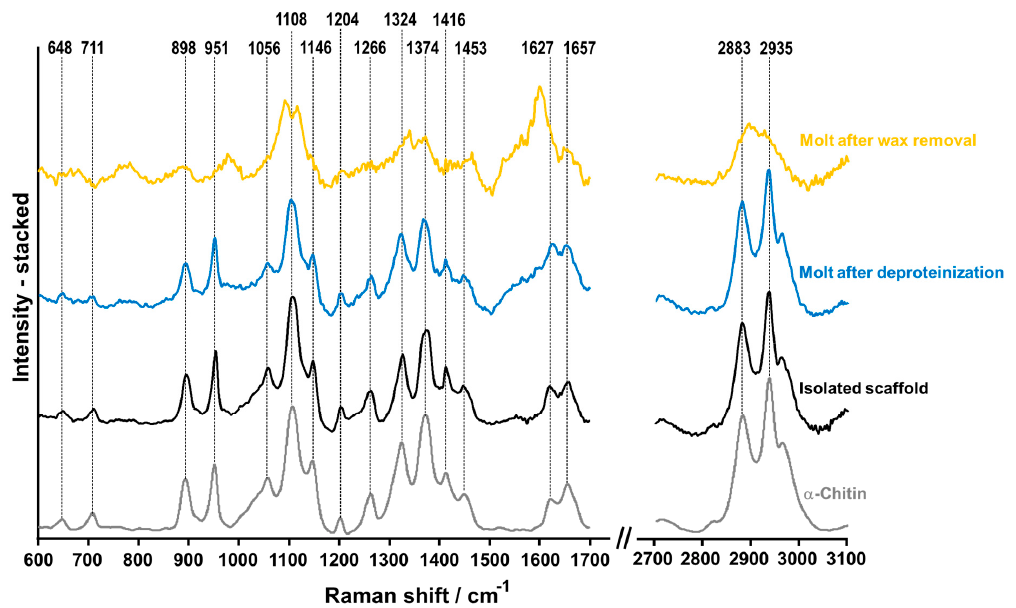
Figure 6. Raman spectra of cuticle after lipid removal (yellow line), molt cuticle after deproteinization (blue line), chitin scaffold from C. versicolor spider isolated using the microwave-assisted approach (black line) and α -chitin standard (gray line).